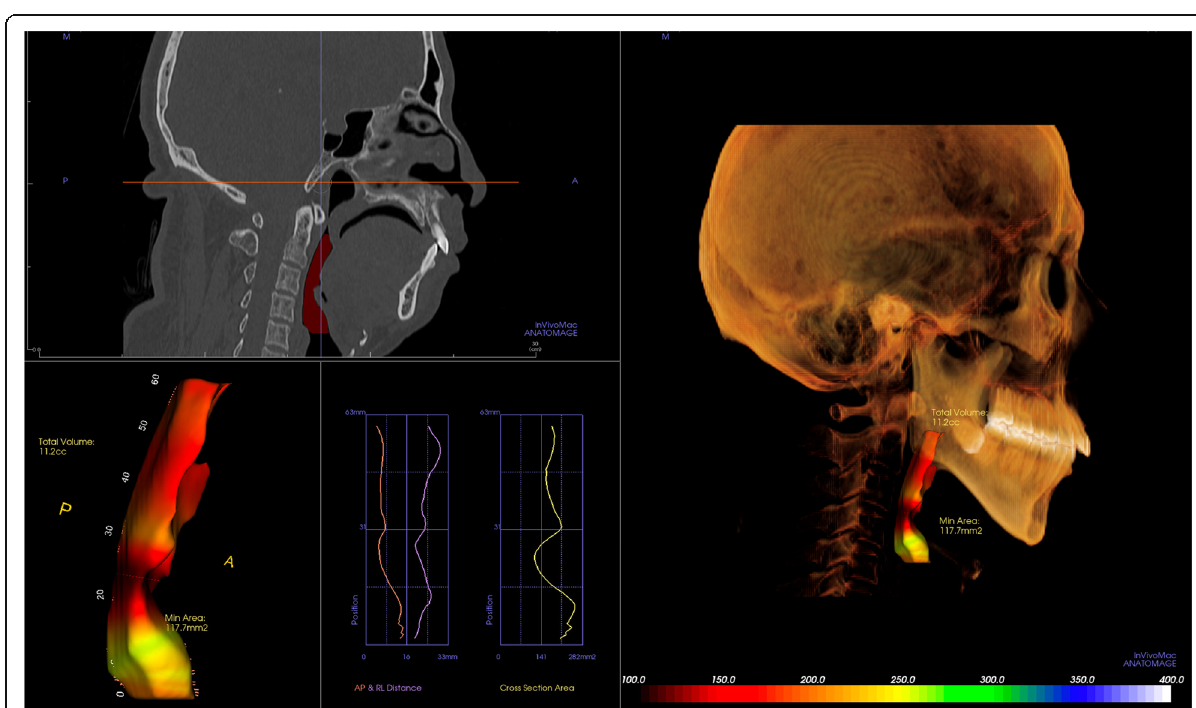
Fig. 1 The volume and shape of the airway can be reconstructed from the CT dataset. Minimal cross-sectional area can be identified and this can be a candidate for a target of a